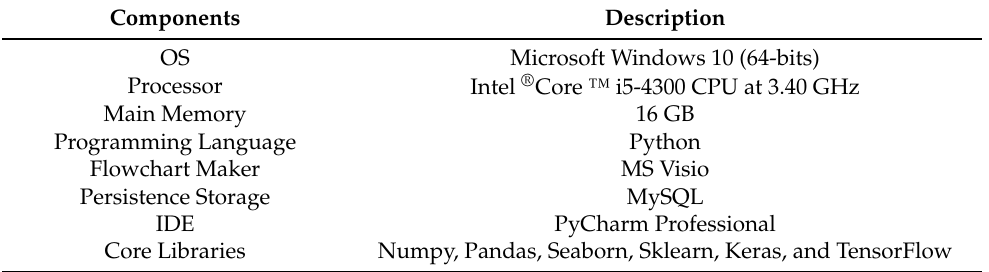
Table 1. Experimental environment of the proposed spatial and temporal ensemble forecasting